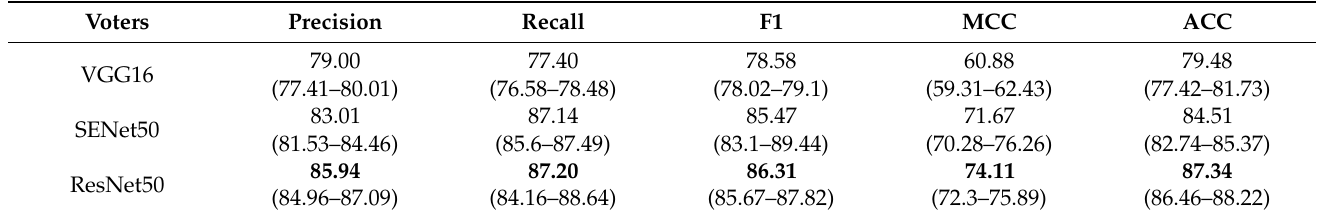
Table 5. Average performance of each voter for all participants.